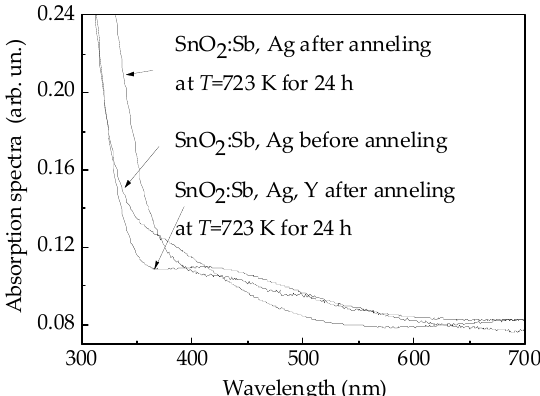
Figure 8. Optical absorption spectra of the thin tin dioxide films SnO 2 :Sb, Ag before annealing and SnO 2 :Sb, Ag as well as SnO 2 :Sb, Ag, Y after annealing at T = 723 K for 24 h.